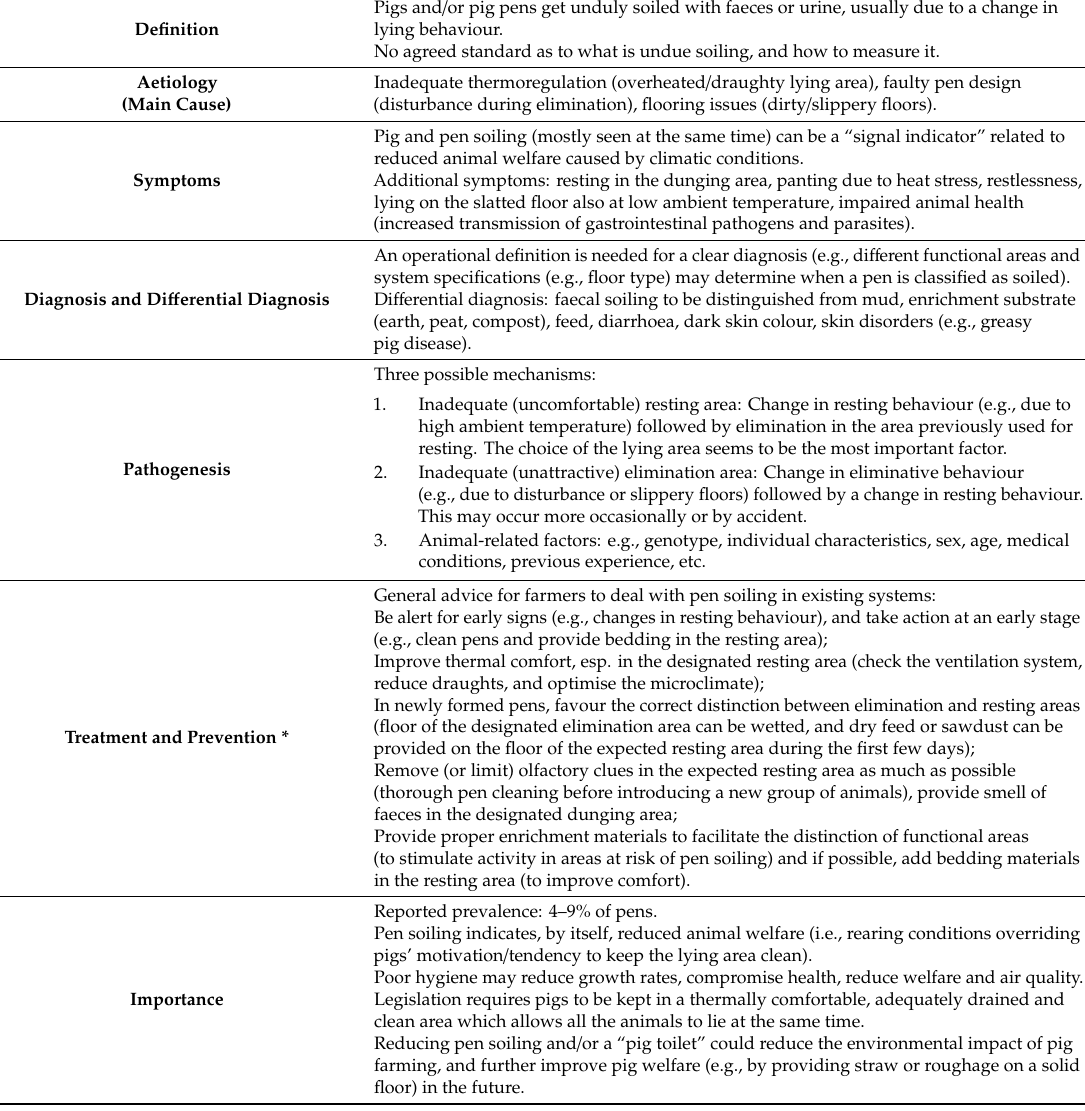
Table 1. Application of the disease framework to pen soiling in existing systems: A